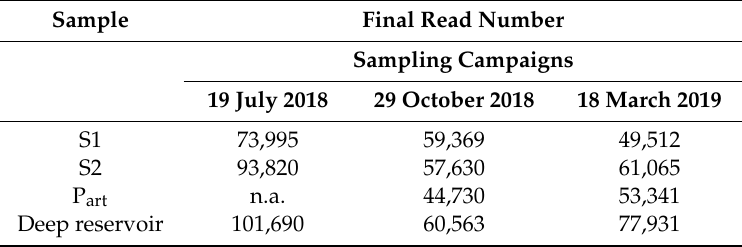
Table 2. Number of 16S rDNA sequences obtained after NGS analysis for the three sampling campaigns (n.a. is not